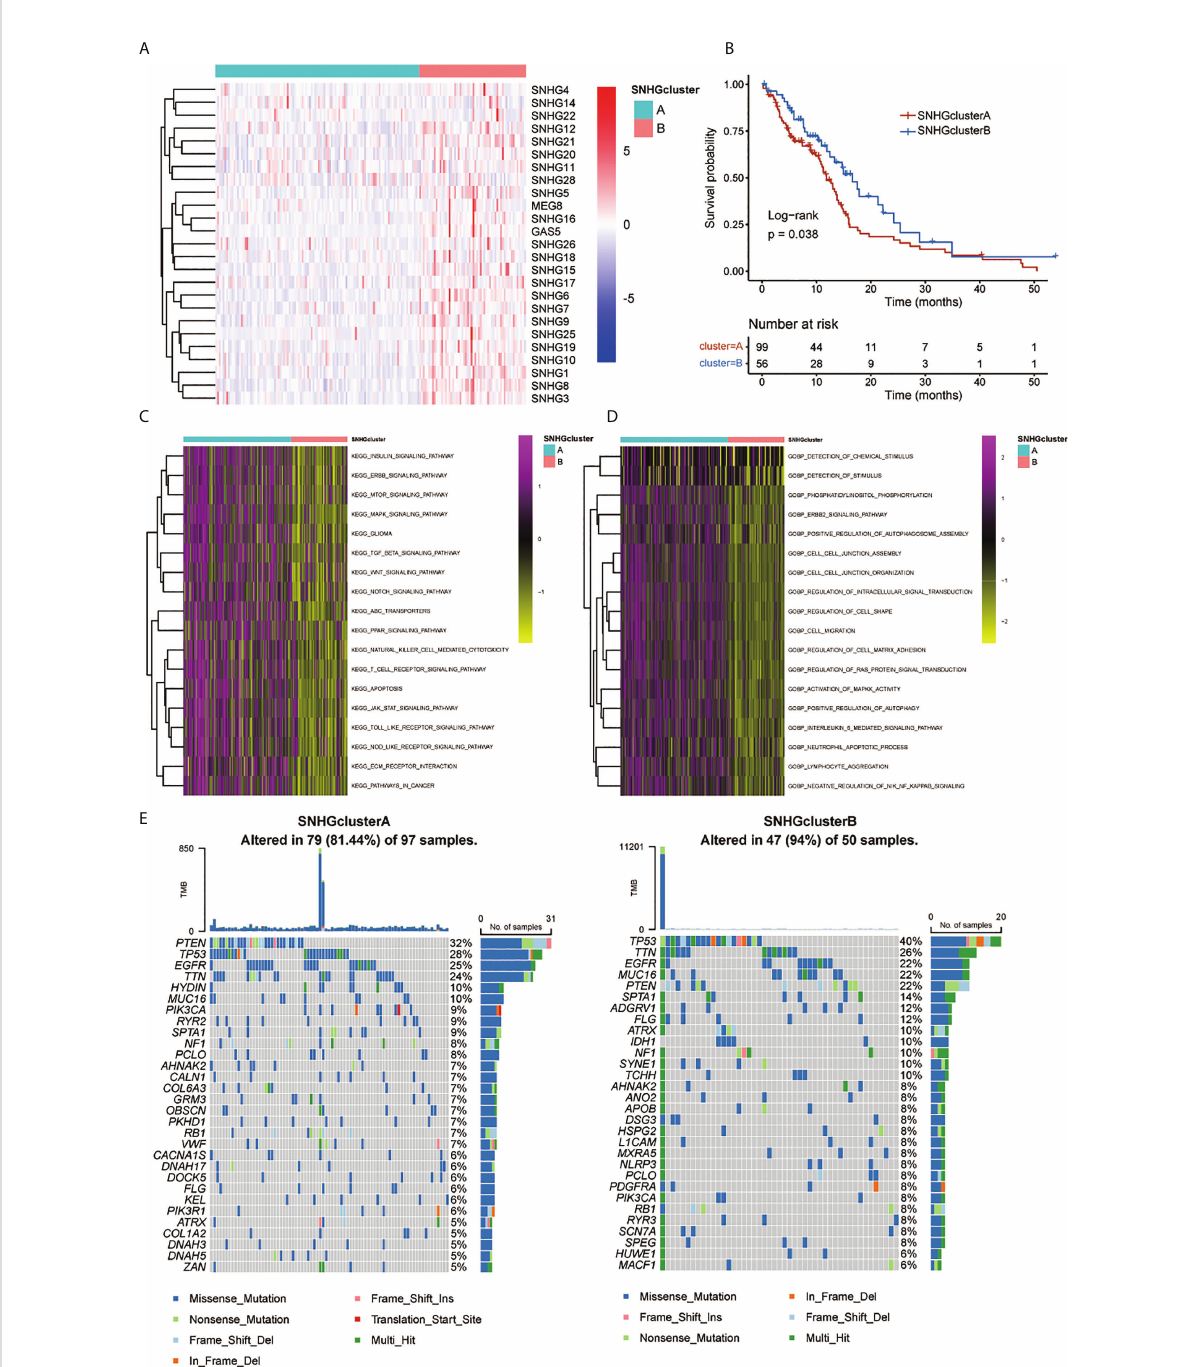
FIGURE 3 Patterns of SNHGs interaction and relative biological features. (A) Heatmap showed expression of 25 SNHGs and clusters in the TCGA GBM samples. (B) Survival analyses for high SNHGclusterA and SNHGclusterB patients using Kaplan-Meier (KM) curves (P = 0.038, Log-rank test). (C, D) GSVA analysis exhibited the enrichment level of diverse biological pathways for different SNHG interaction patterns. c Utilize KEGG genesets; d Utilize GO genesets. (E) The waterfall plot presented the mutations in the top 30 genes among SNHGclusterA and